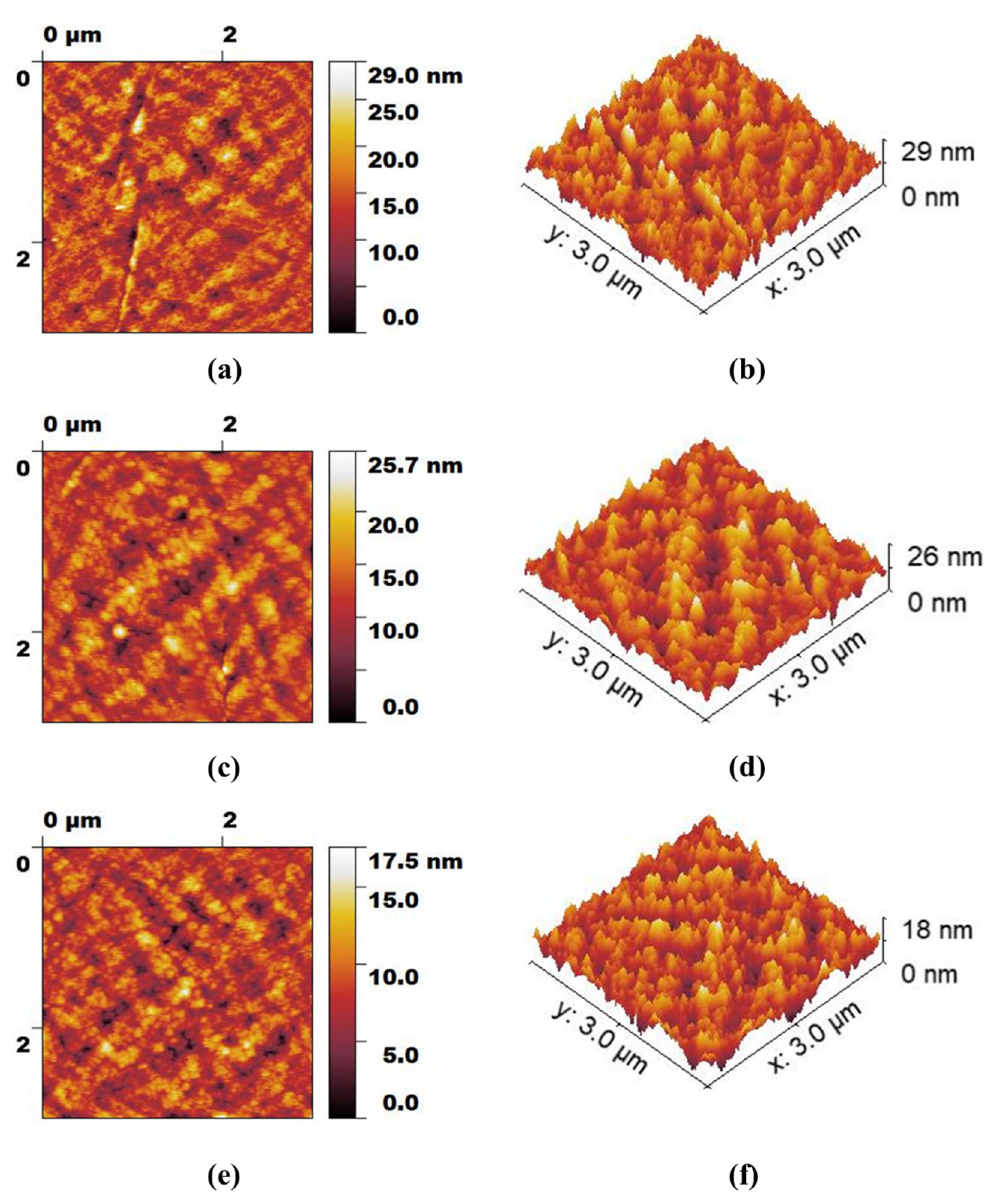
Figure 5. AFM height profiles and 3-dimensional images of M0 ( a , b ), M2 ( c , d ), and M5 ( e , f ) mem- branes.